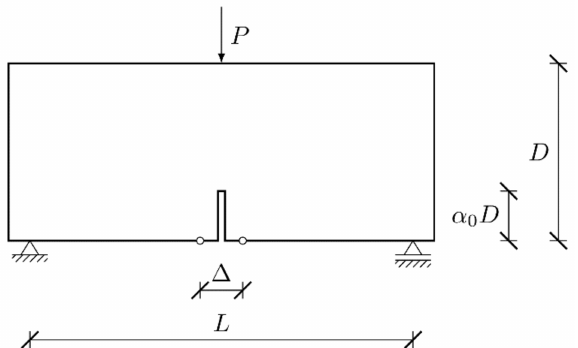
Figure 1. Geometry of the beam and imposed boundary conditions.